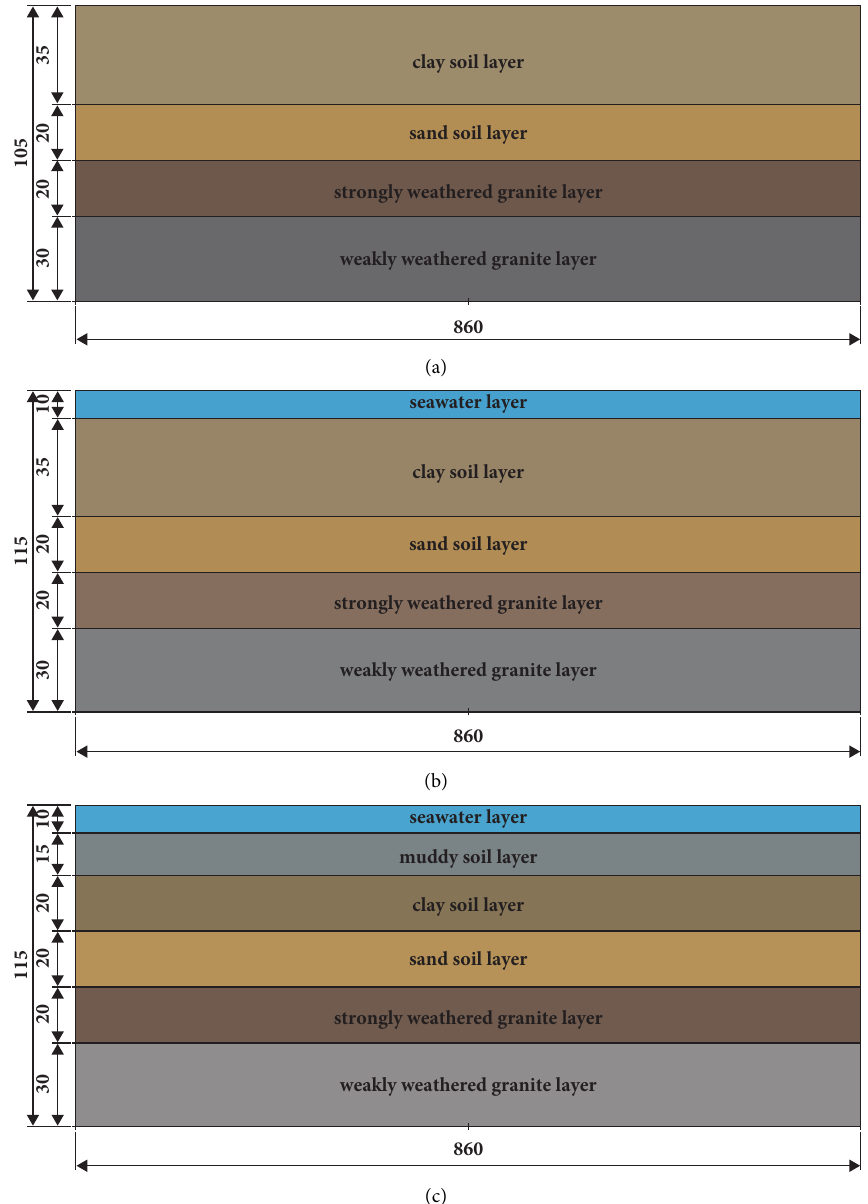
Figure 3: Schematic diagram of site model (unit: m). (a) Case 1: land site model without muddy soil. (b) Case 2: submarine site model without muddy soil. (c) Case 3: submarine site model with muddy